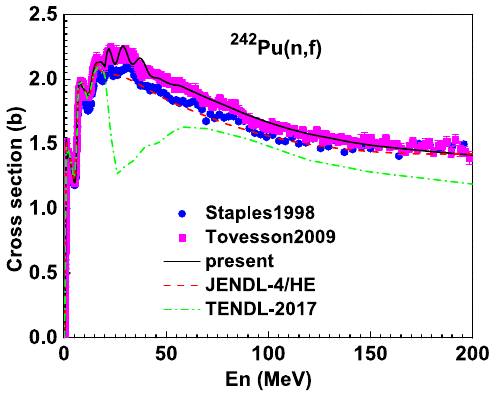
Figure 7. Calculated results of fission cross sections for 240 Pu (solid line), 242 Pu (dashed line), and 244 Pu (dash-dotted